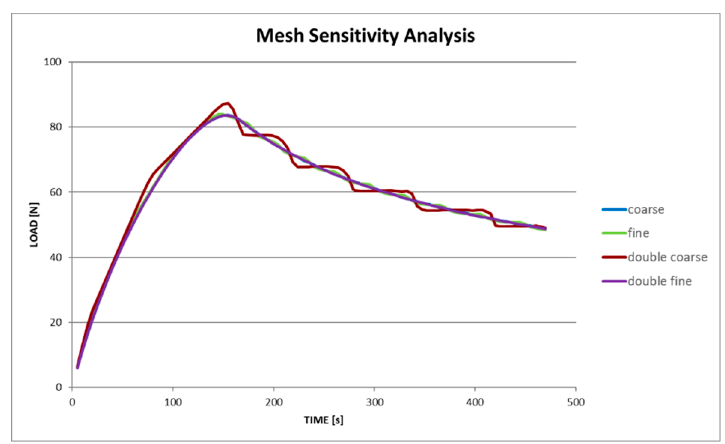
Figure 9 . Mesh sensitivity analysis: result comparison . Figure 9. Mesh sensitivity analysis: result comparison.